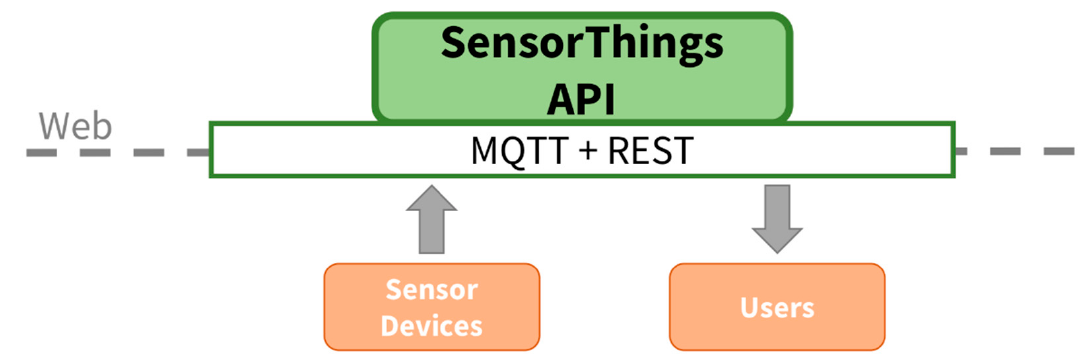
Figure 8. SyPEAH, STA protocol.